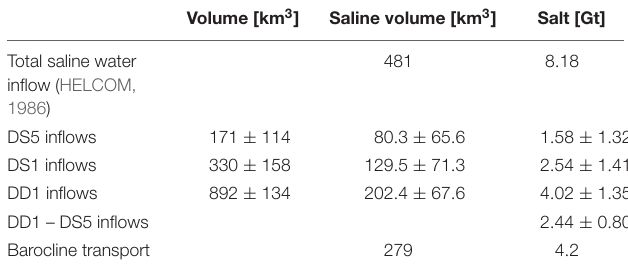
TABLE 3 | Contribution of barotropic inflows to the total annual salt import of the Baltic.